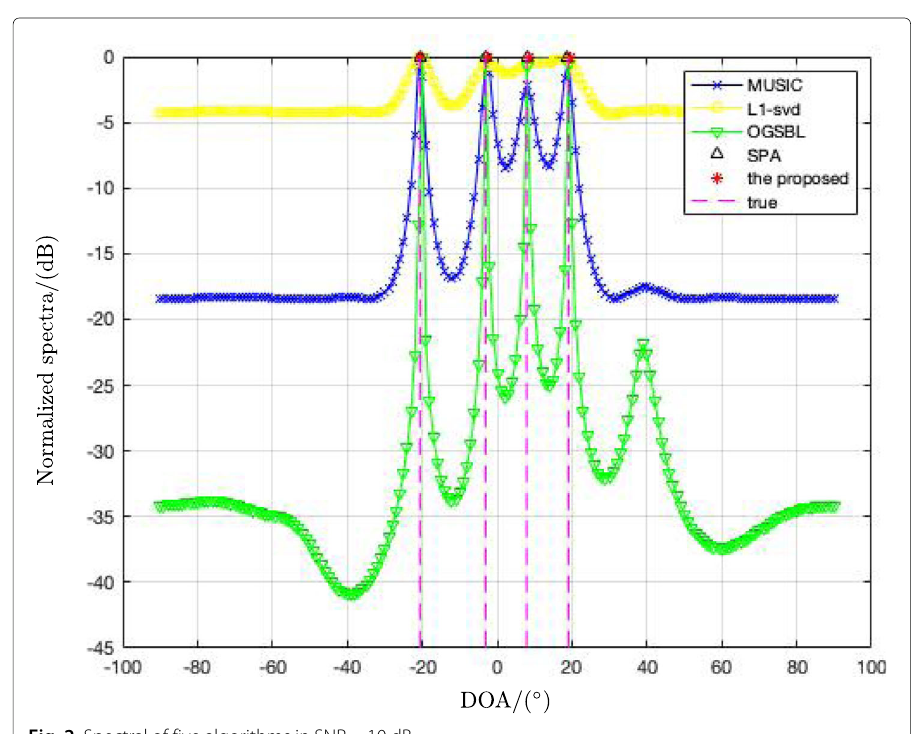
Fig. 2 Spectral of five algorithms in SNR = 10